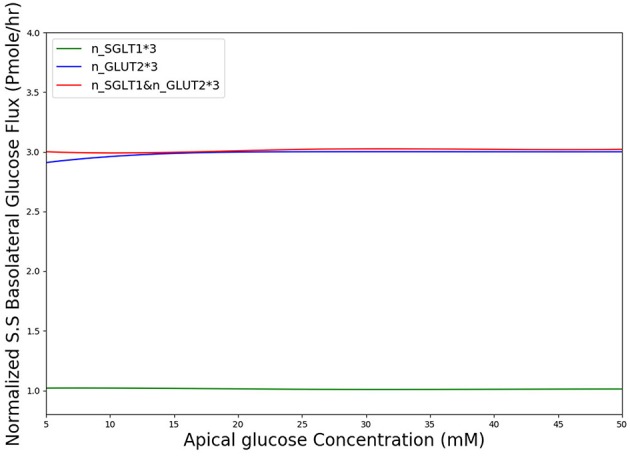
Normalized steady state basolateral glucose flux vs. different stimulus of glucose in the lumen when number of SGLT1 is 3-fold higher(green), number of GLUT2 is 3-fold higher(blue) and number of both SGLT1 & GLUT2 are 3-fold higher(red).